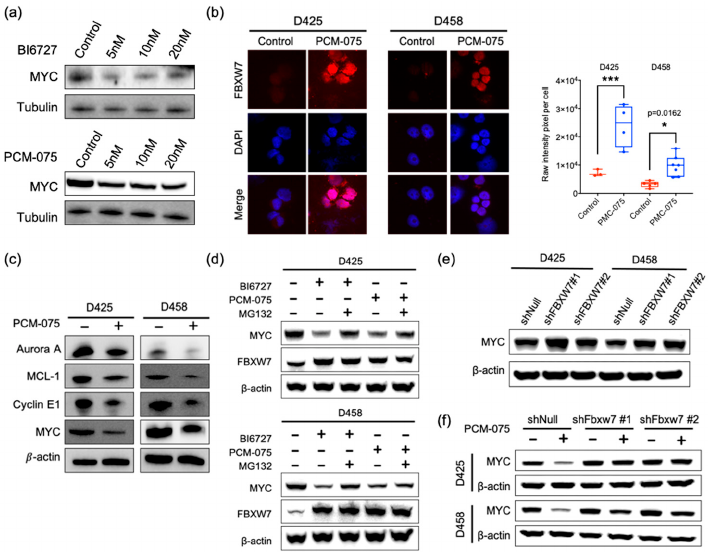
Figure 2. PLK1 antagonizes FBXW7-mediated degradation of c-MYC. ( a ) Western blot of c-MYC and tubulin with various concentrations of 5–20 nM BI6727 or PCM-075 treatment in D458 cells for 48 h. The quantification plot can be found in Figure S2c. ( b ) Representative immunofluorescence of FBXW7 in D425 and D458 cells treated with 10 nM PCM-075 for 48 h. Results are representative of three independent experiments. ( c ) Western blot of AURORA A, MCL-1, Cyclin E1, c-MYC and β -actin. D425 and D458 cells were treated with 10 nM PCM-075 for 48 h. The protein levels were analyzed by immunoblot, with β -actin as a loading control. ( d ) PLK1 sustains MYC through FBXW7. D425 and D458 cells were treated with BI6727 (10 nM) or PCM-075 (10 nM) for 48 h. For MG132 treatment, cells were treated with MG132 (10 mM) for 6 h before harvest. FBXW7 and c-MYC protein